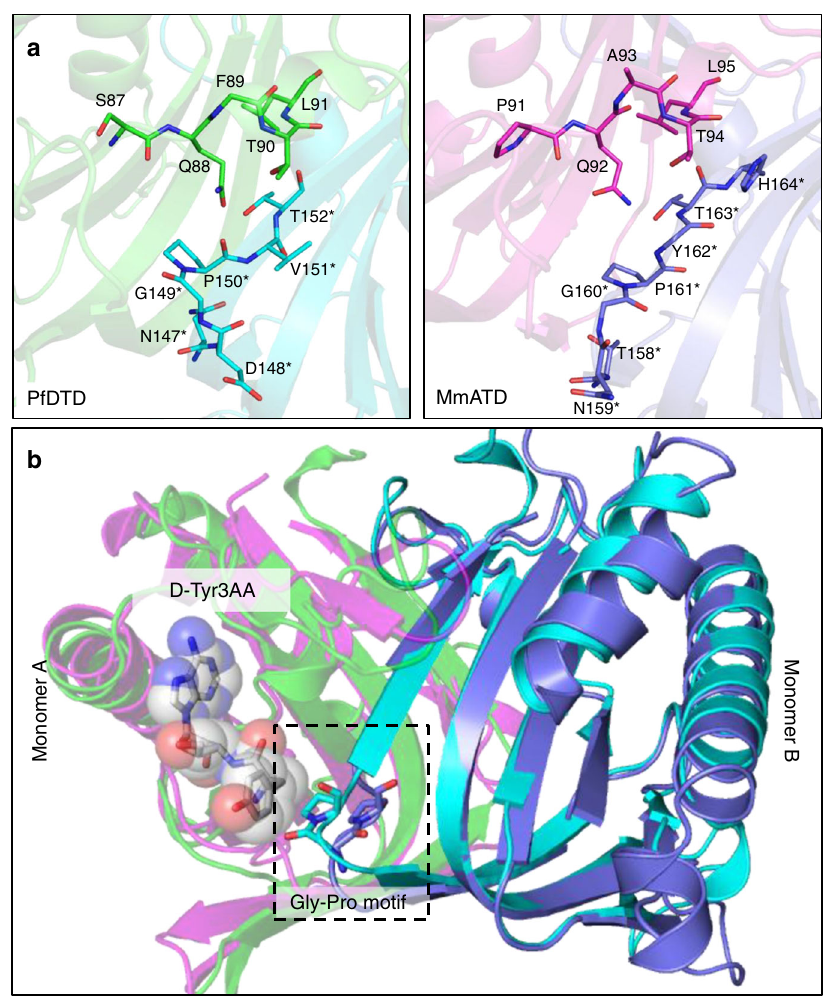
Fig. 2 ATD has similar active site features as compared to DTD ’ s. a Crystal structures of PfDTD (PDB id: 4NBI) and MmATD showing that motifs 1 and 2 form the active site at the dimeric interface in both. b Structural superposition of MmATD on PfDTD displaying the cross-subunit Gly-Pro motif in both, i.e., the motif from one monomer inserted into the active site of the other monomer. Residues from the dimeric counterpart are indicated by